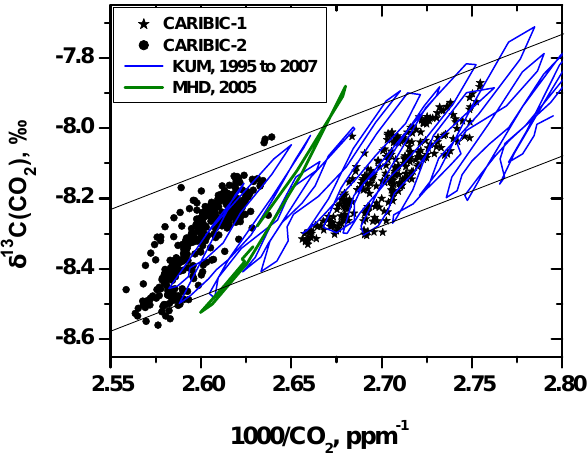
Fig. 11. Keeling plot for CARIBIC-1 and CARIBIC-2 (data not de- trended) including data for KUM (1993 to 2007) and MHD (2005). The two enveloping lines correspond to the slope of the KUM inter- annual trend, and give upper and lower limits of the variability. CARIBIC data agree well with the range demonstrated by the trop- ical